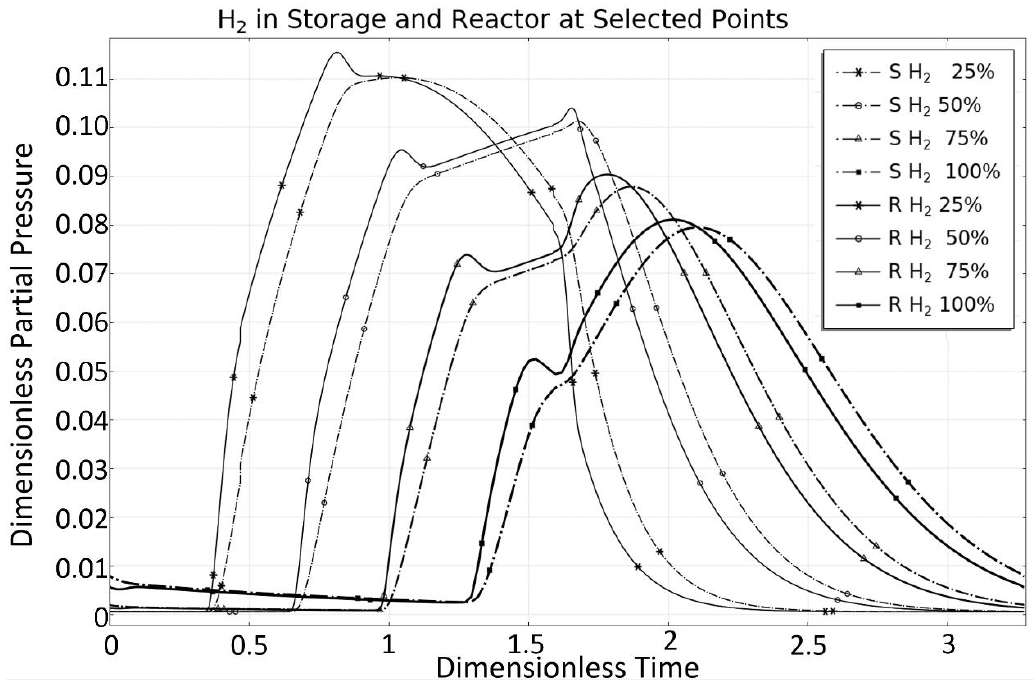
Figure 11. Dimensionless time evolution of H 2 dimensionless partial pressure in void and storage domains at four reactor lengths for the last cycle for Da = 4, Θ = 50.